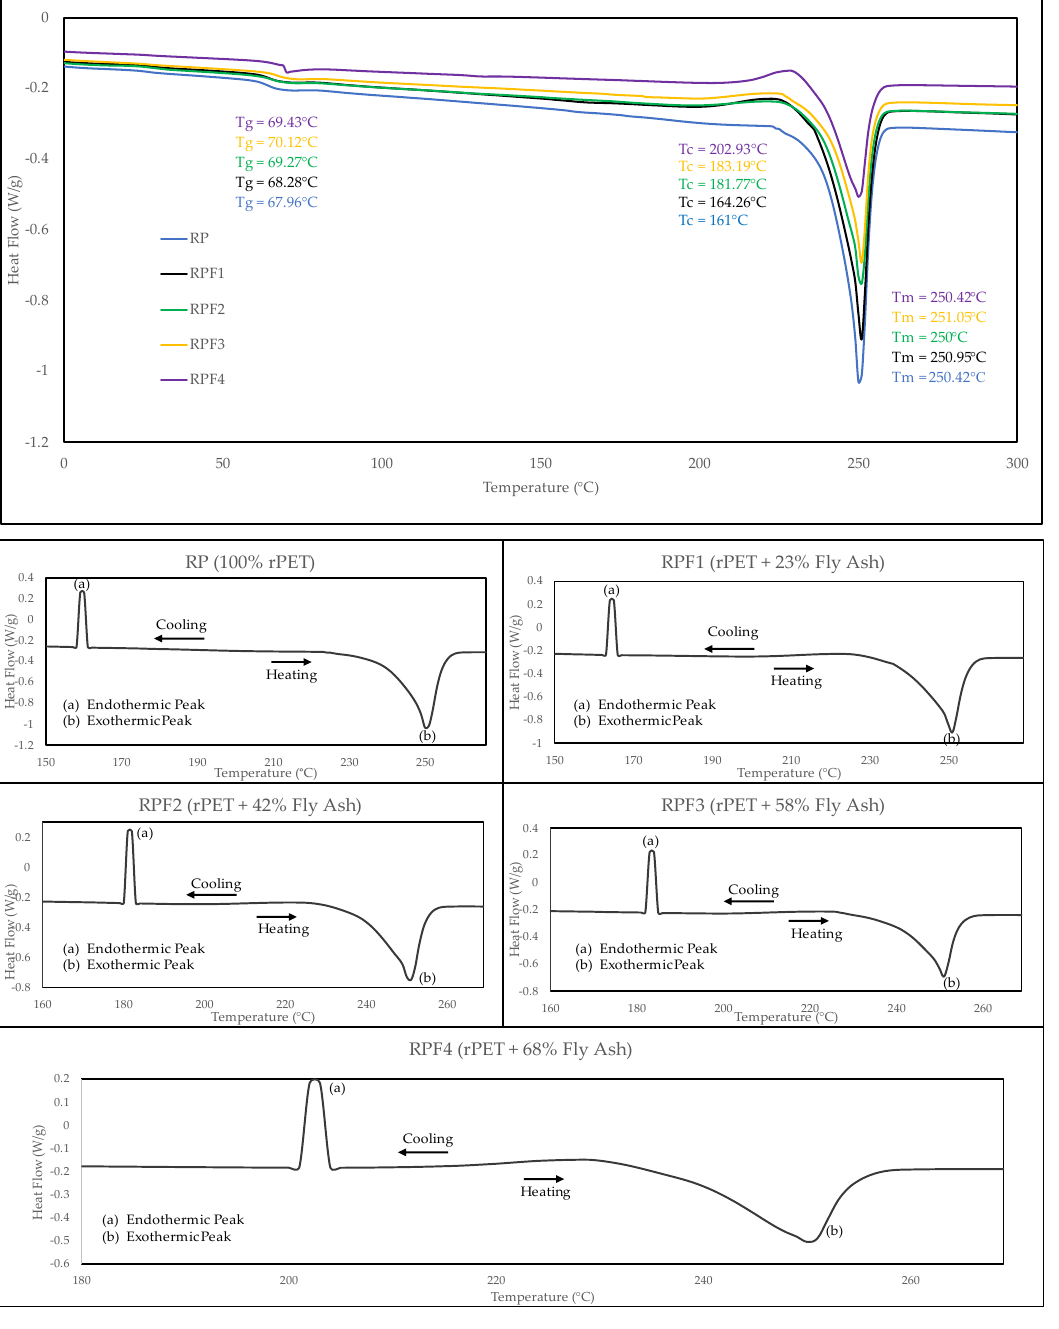
Figure 1. DSC thermograms of 100% rPET (RP), rPET with 23% fly ash (RPF1), rPET with 42% fly ash (RPF2), rPET with 58% fly ash (RPF3), and rPET with 68% fly ash (RPF4).